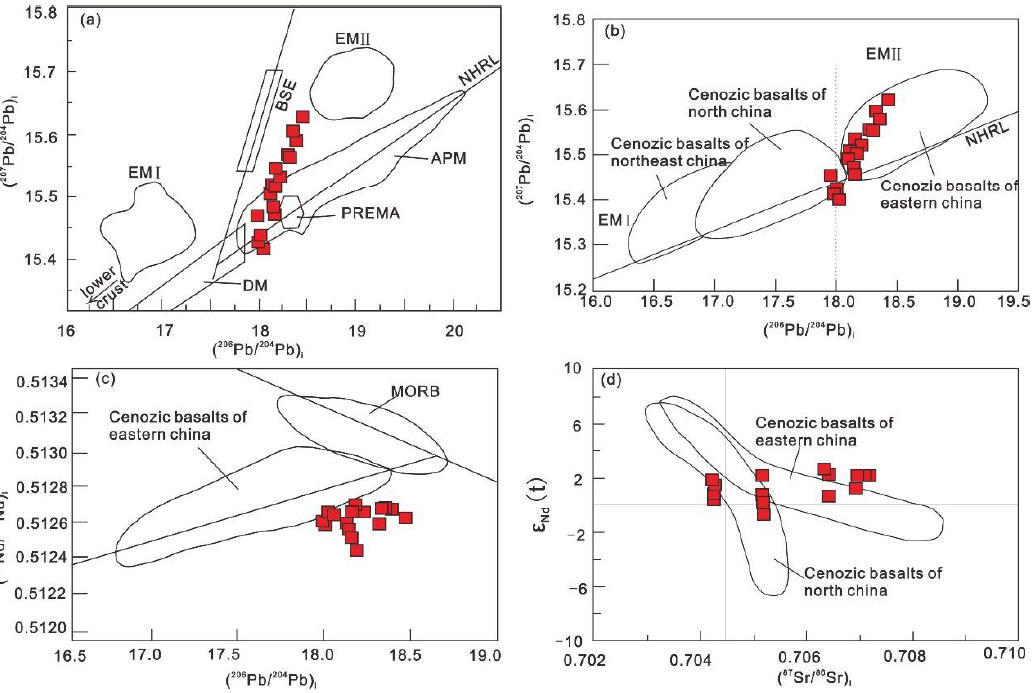
Figure 9. Plots of 207 Pb/ 204 Pb(i) vs. 206 Pb/ 204 Pb(i) ( a , b ), 143 Nd/ 144 Nd(i)vs. 206 Pb/ 204 Pb(i) ( c ) and ε Nd (t) vs. 87 Sr/ 86 Sr ratios ( d ) of the volcanic rocks from the Jiangling Basin. Cenozoic basalts of Eastern China from [49,50]; Cenozoic basalts of Northern China from [28,36]; Cenozoic basalts of Northeast China from [36]; EMI and EMII and DMM from [79].